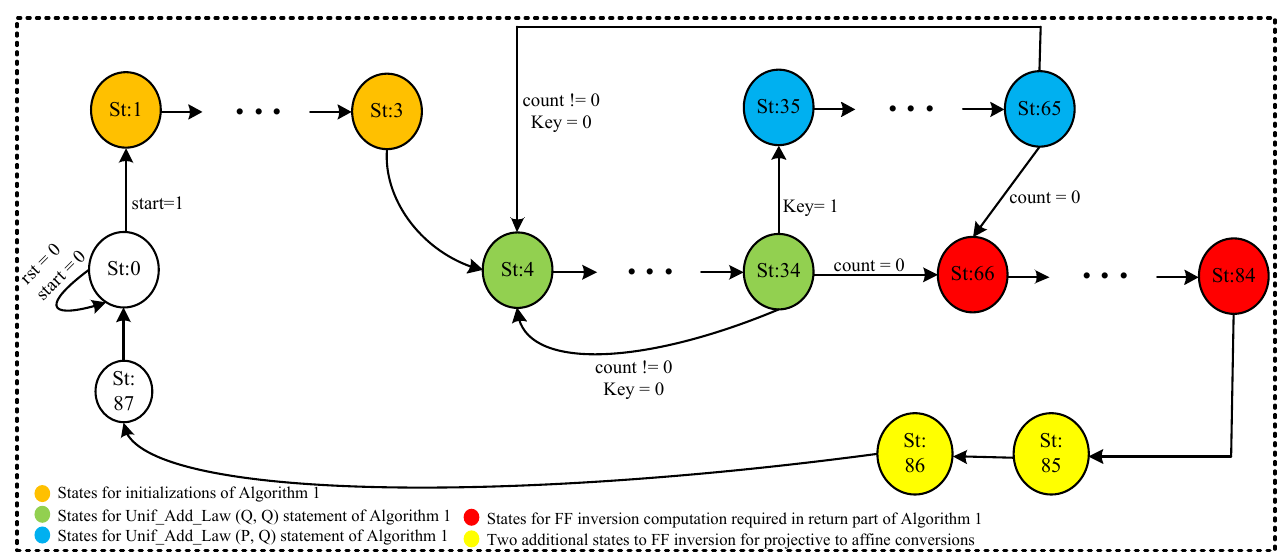
Figure 3. FSM of the proposed architecture.